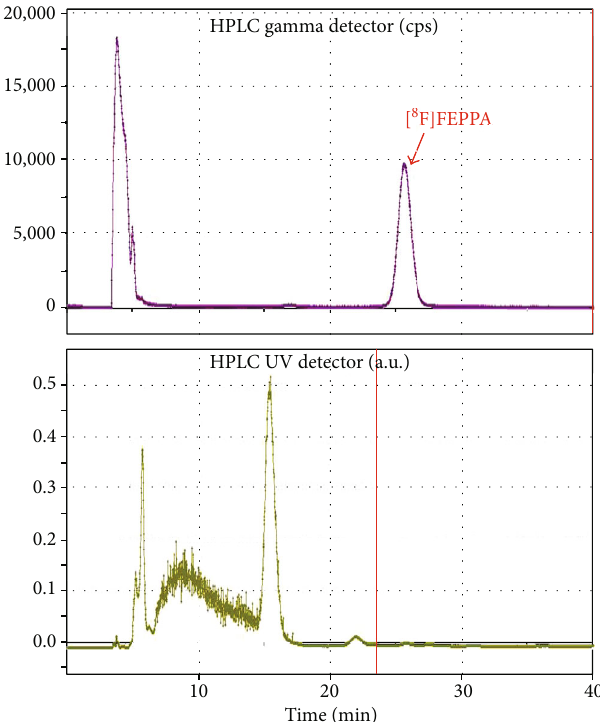
Figure 5: Representative semipreparative HPLC puri fi cation chromatogram of the [ 18 F]FEPPA